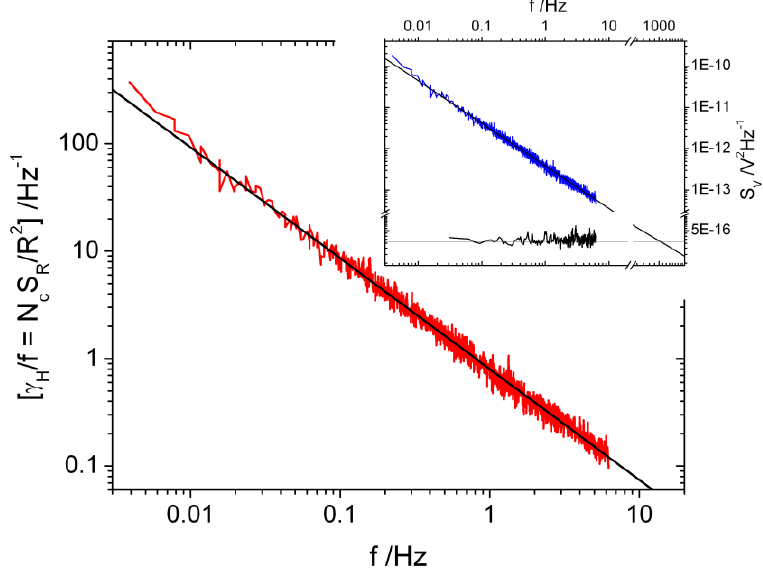
Figure 5. Normalized resistance noise power spectral density (PSD) of a Pt-sensor with dimensions 15.1  m  1.3  m  0.28  m taken at room temperature. Inset: Voltage noise PSDs taken at currents I = 38.8  A (blue) and I = 0 (black). The black curve corresponds to thermal noise, whereas the blue curve can be fitted to with a slope  = 1.03. S  1/ f